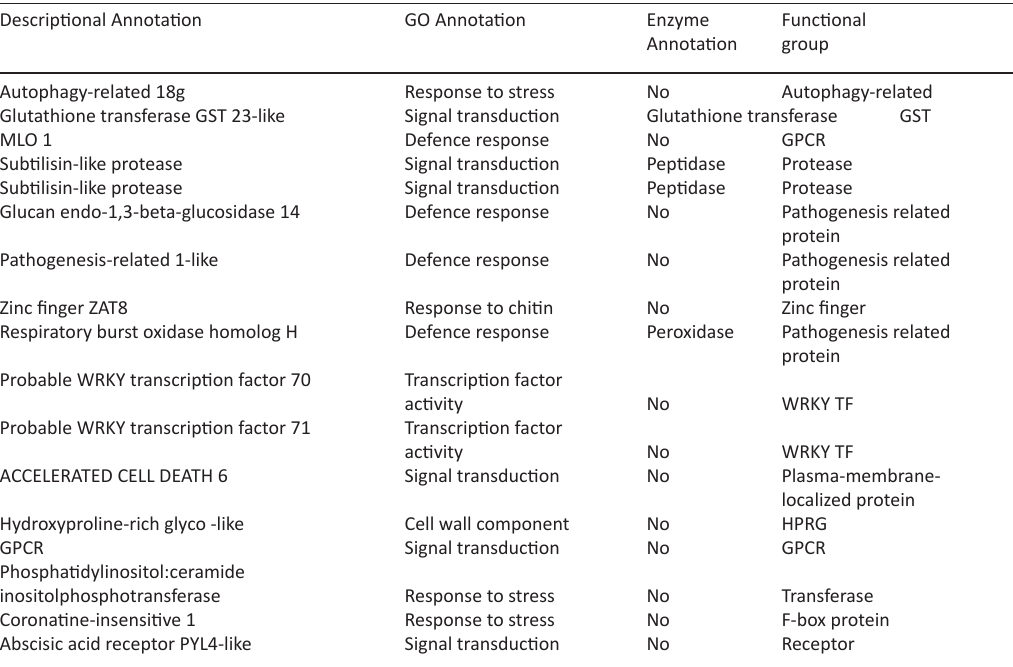
Table 4. List of defence related genes in qLBL5 with annotations and functional groups Descriptional